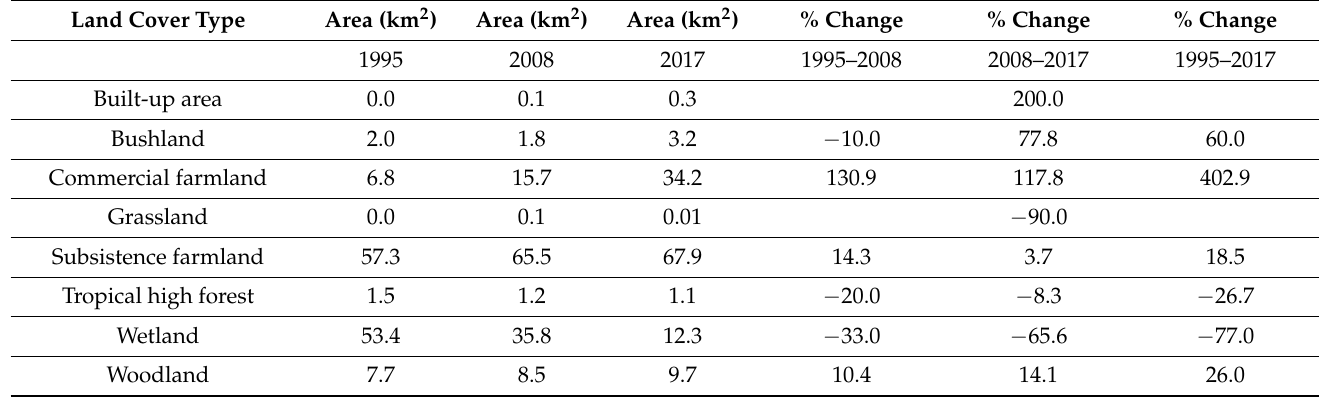
Table 5. Flooded areas (km 2 ) in different Land cover types (1995–2017).